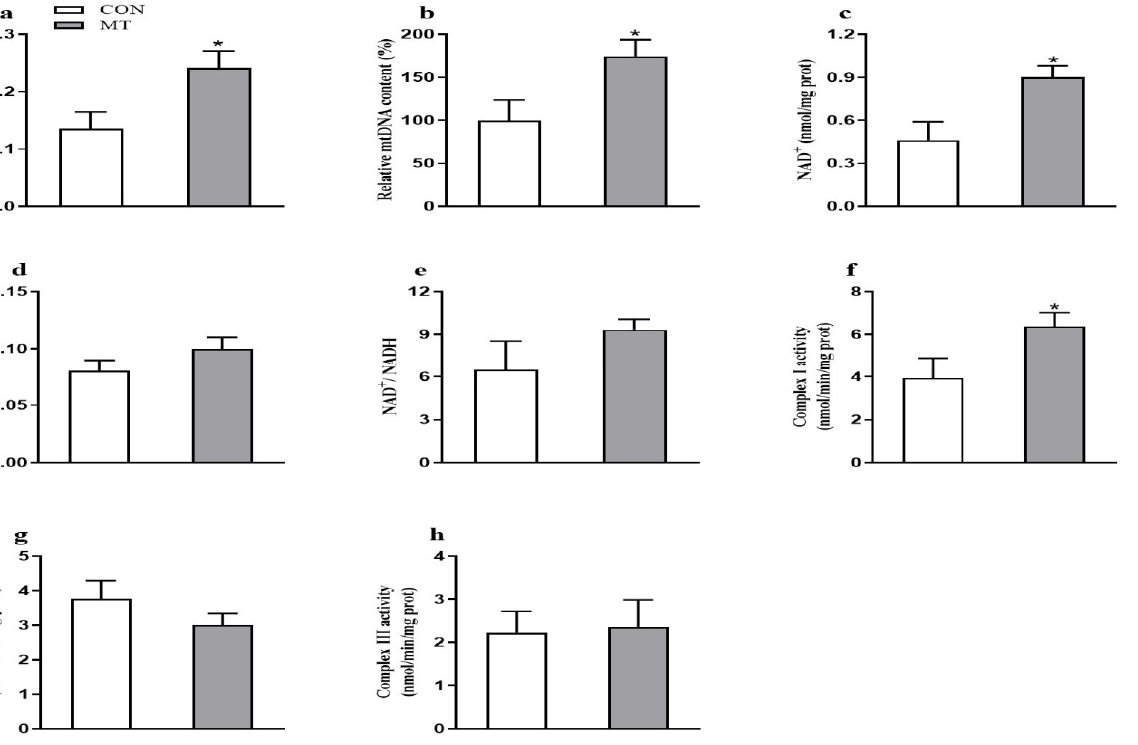
Figure 6. Effects of maternal MT supplementation during gestation on Sirt1 protein ex- pression in placenta. Data are presented as means ± SEM, n = 6. * p < 0.05. CON = control, MT = melatonin.